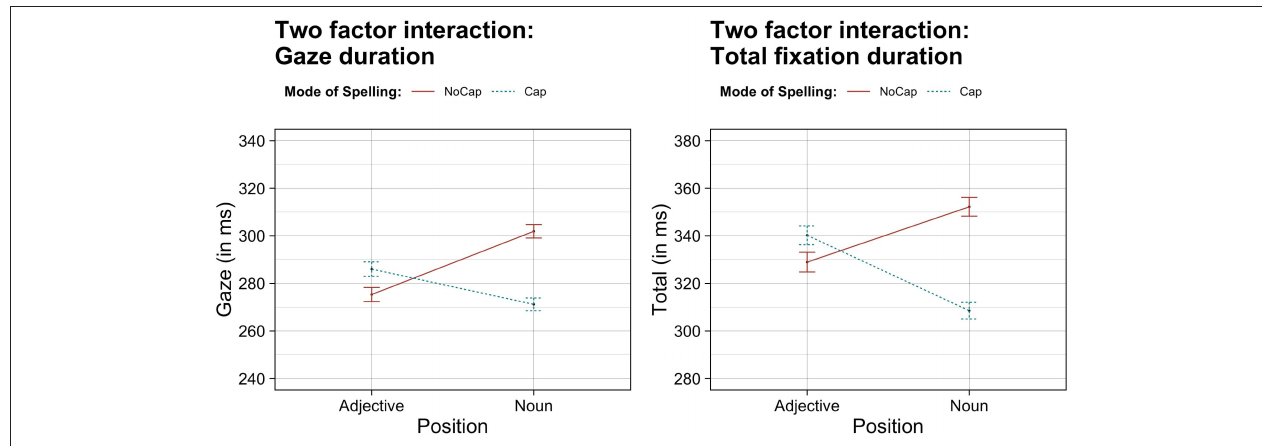
FIGURE 1 | Estimated values of the two factor interactions of SPELLING (Cap vs. NoCap) and POSITION (Adjective vs. Noun) (cf. Table 2 ) in Gaze duration (to the left) and in the Total fixation duration (to the right); error bars represent the standard errors. The blue (dotted) lines represent sentences that follow German standard orthography; the red (solid) lines represent sentences in which the nouns are not capitalized.